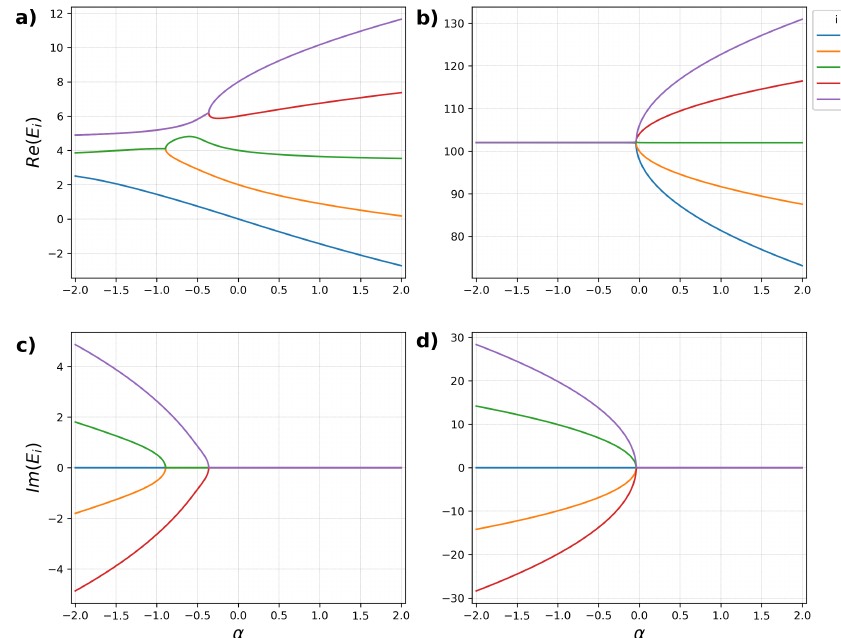
Figure 1. The behavior of the eigenvalues of H of Equation (2) are displayed as a function of α . The diagonalization was performed for a system with N s = 4, Ω = 2 and x = 1. Panels ( a , b ) correspond to values of L = 2, and ( c , d ) to values of L = 100. We plot the real part of the eigenvalues in ( a , c ), and the imaginary part in ( b , d